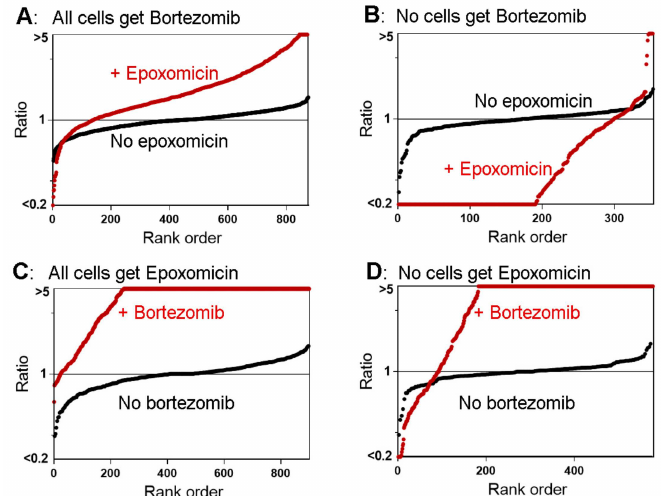
Figure 4. Summary plots of the peptidome of HEK293T cells in response to proteasome inhibitors. ( A ) Cells were treated for 30 min with a combination of 0.2 µ M epoxomicin and 0.5 µ M bortezomib or with 0.5 µ M bortezomib alone (all in the presence of 0.05% DMSO). ( B ) Data from a previously published study in which cells were treated with 0.2 µ M epoxomicin in 0.05% DMSO, or 0.05% DMSO alone for 1 h [21]. ( C ) Cells were treated for 30 min with a combination of 0.2 µ M epoxomicin and 0.5 µ M bortezomib or with 0.2 µ M epoxomicin alone; all samples included 0.05% DMSO. ( D ) Data from a previously published study in which cells were treated with 0.5 µ M bortezomib in 0.05% DMSO or with 0.05% DMSO for 30 min [27]. The y-axis represents the relative levels of peptides (log-scale) and the x-axis represents the rank order of peptides sorted according to the relative level. If the ratio was < 0.20 or > 5.0, the value was capped at 0.20 or 5.0 to reflect the typical signal-to-noise ratio. Red circles indicate the ratio of each replicate of identified peptides in cells treated with the combination of epoxomicin and bortezomib in panels A and C and either inhibitor alone in panels B and D, expressed relative to the average of the respective controls (i.e., for panel A, the red circles represent the relative level of each peptide in cells treated with both inhibitors relative to cells treated with bortezomib alone, while, for panel C, the red circles represent the relative level of each peptide in cells treated with both inhibitors relative to cells treated with epoxomicin alone). Black circles indicate the ratio of each control replicate expressed relative to the average control value (either bortezomib or epoxomicin alone in panels A and C; DMSO in panels B and D). See Figure S2 for details on the treatments of cells for each of these peptidomic